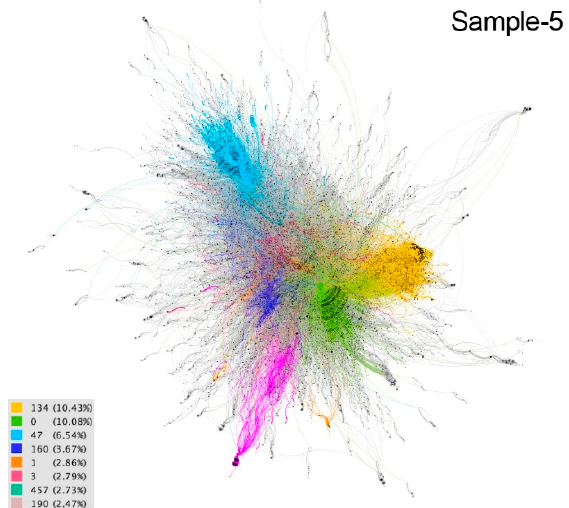
Figure 6. Graph of sample 5. Community detection based on modularity [66] and according to intermediation centrality [63] of sample 1. Source: Gephi